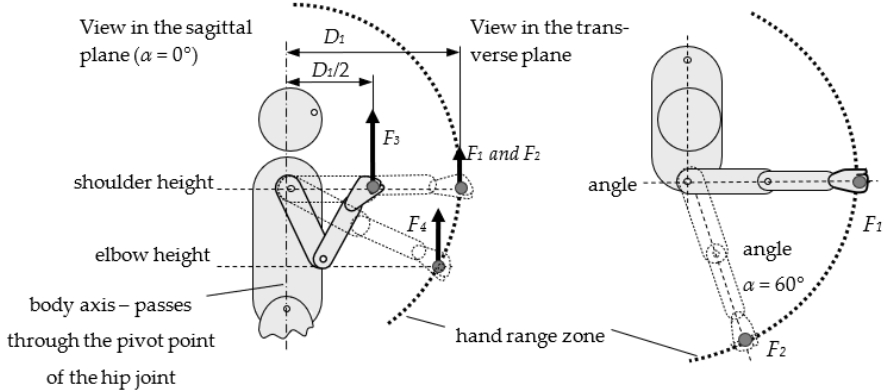
Figure 3. Measuring points during simplified measurements and A u model determination (explana- tions: F 1 n , the strength of the upper limb at the full range D 1 at shoulder height ( α = 0°); F 2 n , the strength of the upper limb at the full range D 1 at shoulder height for ( α = 60°); F 3 n , the strength of the upper limb at midrange D 1 n /2 at shoulder height ( α = 0°); F 4 n , the strength of the upper limb at full range D 1 at elbow height ( α = 0°); D 1 , arm range within the plane α = 0° at shoulder height; D 1 n /2, arm midrange within the plane α = 0° at shoulder height.